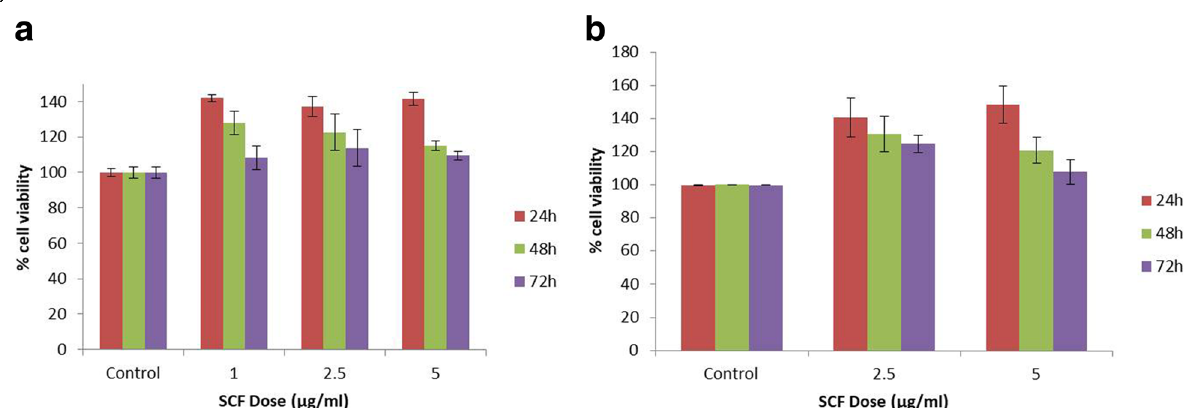
Fig. 11 a Cytotoxicity of SCF on A-549 cells using MTT assay. SCF was tested for its cytotoxicity at different dosages on A-549 cultured cells. Cells were treated with various dosages of SCF for 24, 48, and 72 h. Cell viability was depicted as percentage of viable cells, taking untreated cells served as control (regarded as 100% viable cells); ( n = 4 replicates). b Resazurin reduction assay to study effects of SCF on viability of A-549 cells. Effect of SCF on viability of A-549 cells was assayed in a dose-dependent manner. Untreated cells were considered as 100% viable. Viability of